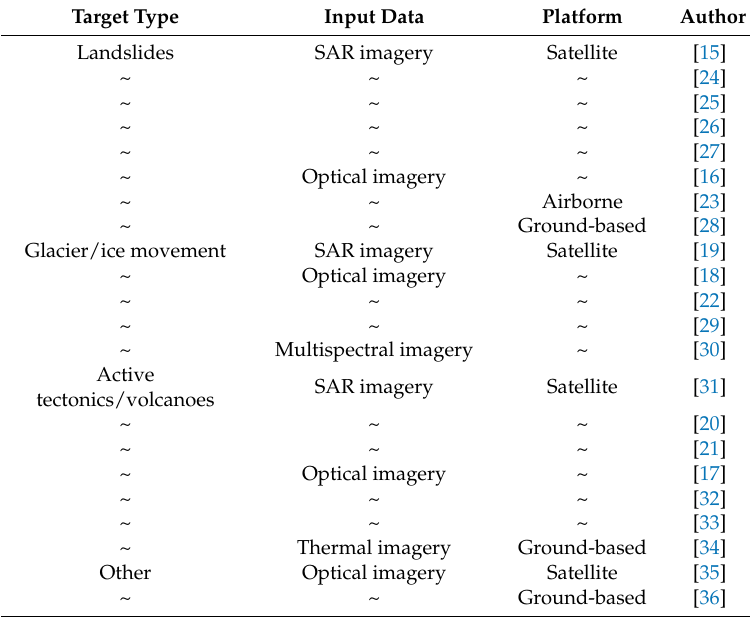
Table 1. Examples for digital image correlation (DIC)